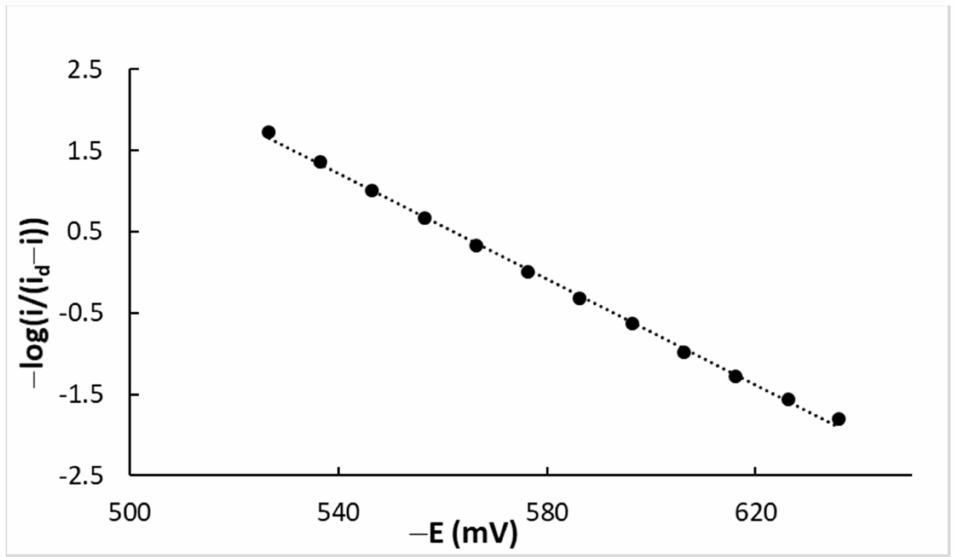
Figure 2. Plot of log(i/(i d − i)) vs. E for Cd(II) in 0.55 M perchloric acid solution. The values of D O obtained with the Ilkovic equation are higher than those reported in the bibliography (even the experimental conditions of the concentration and